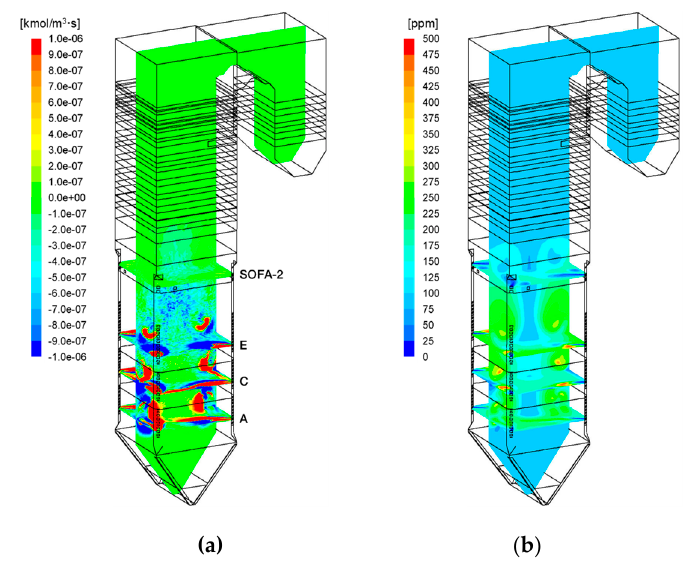
Figure 6. Reaction rate and concentration of NO for the reference case (C05-S20). ( a ) NO rate and ( b ) NO concentration.